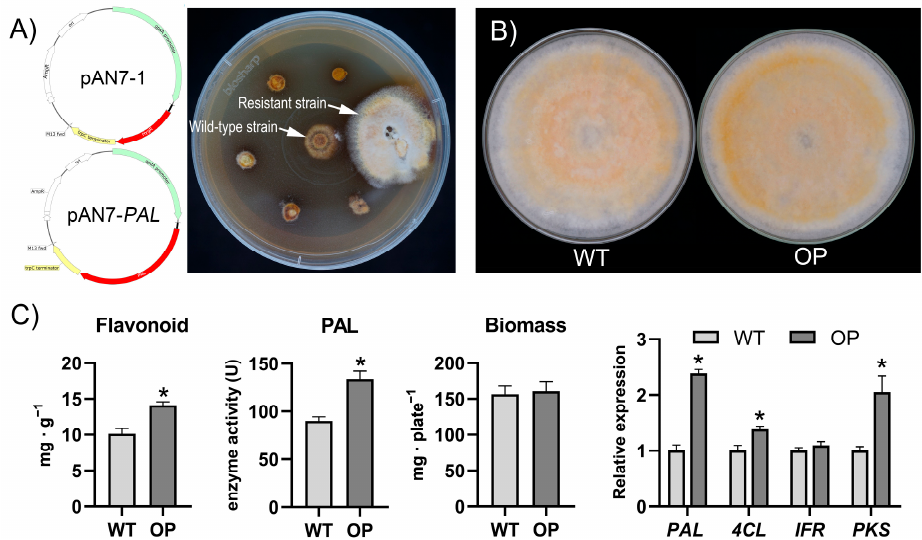
Effects of SbPAL overexpression on the accumulation of flavonoids in S. baumii . ( A ) Plasmids used for overexpression and the hygromycin-resistant colony obtained from 30 days culture on hygromycin plates. The wild-type (WT) strain is in the middle of the plate as a control. ( B ) Colonies of WT and SbPAL -overexpressing strain (OP). ( C ) Differences in total flavonoid content, PAL enzyme activity, biomass, and gene expression between the WT and OP strains. The values with * are significantly different ( p < 0.05).